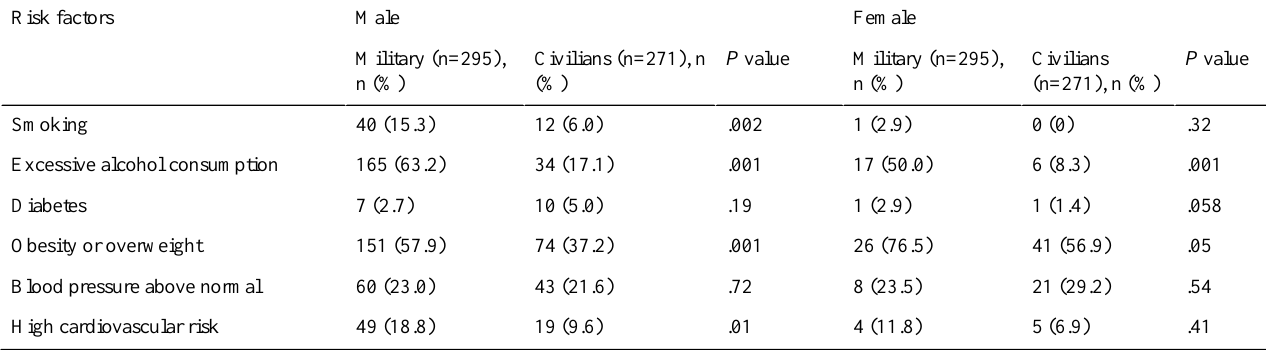
Table 3. Distribution of cardiovascular risk factors by gender.